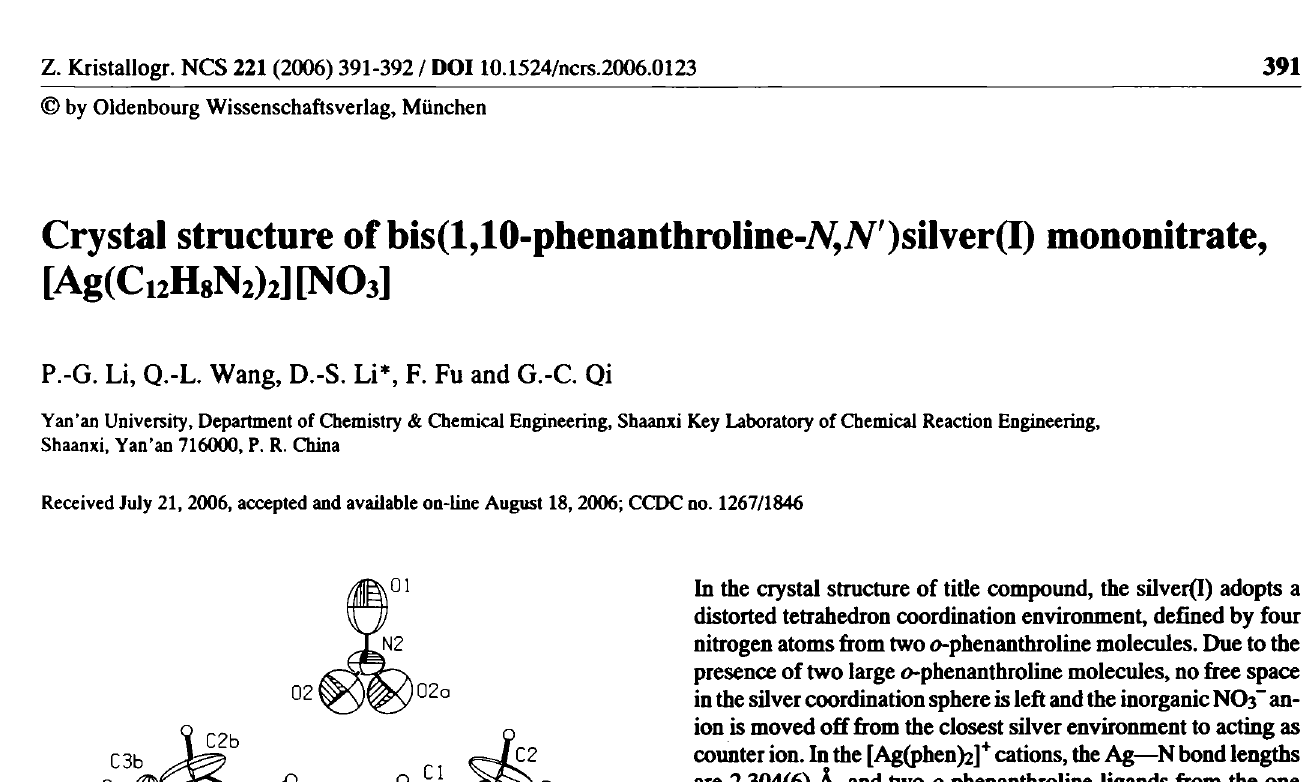
Table 1. Data collection and handling.